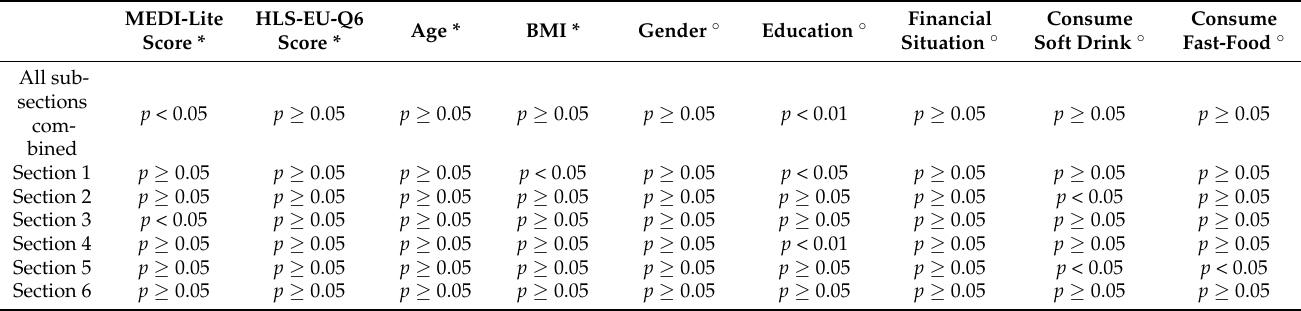
Table 4. Associations between NLit-IT score (for each section and all subsections combined) and the following variables: MEDI-Lite score, HLS-EU-Q6 score, age, BMI (kg/m 2 ), gender, educational level, financial situation, consumption of soft drink or